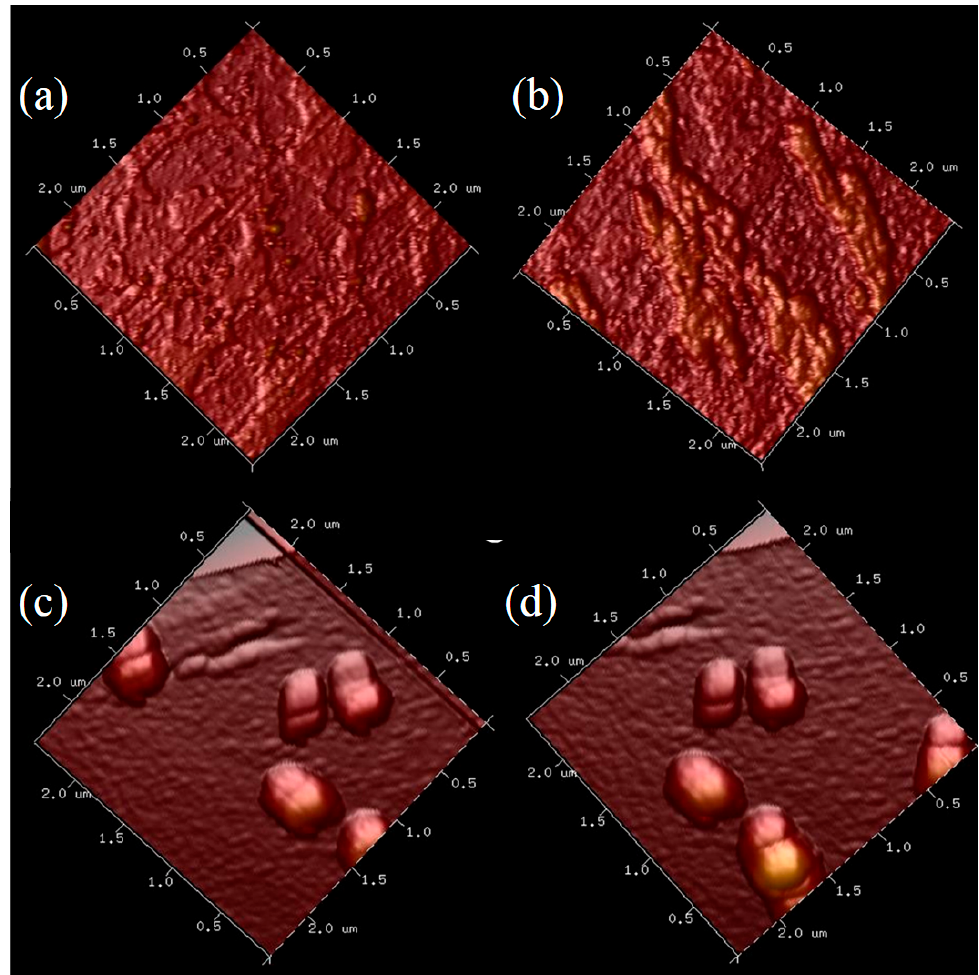
Figure 9. PXRD patterns for ( a , b ) 6cazpy crystal and ( c , d ) complex-I crystal before, during and after UV irradiation. ( b ) The peak at 2 θ = 4.782°of 6cazpy, ( d ) 2 θ = 9.179°of complex-I crystals before, during and after UV irradiation.